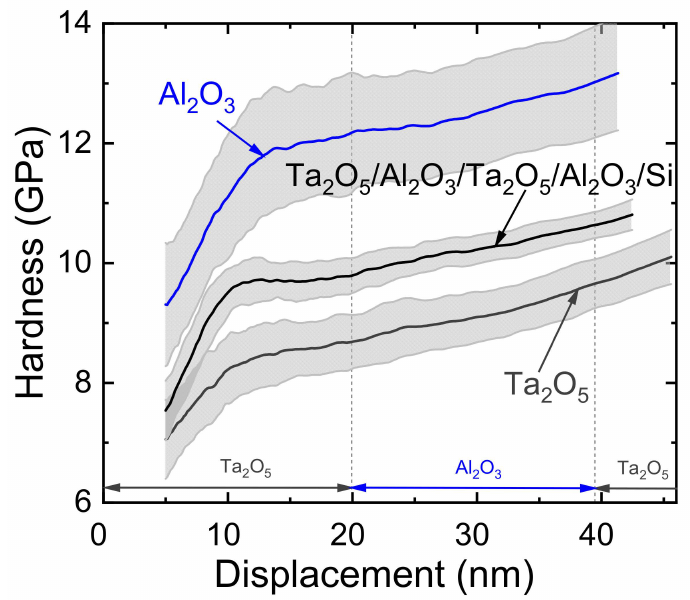
Figure 4. Averaged hardness of 15 indents with standard deviation shown as grey areas. Verti- cal dotted lines and arrows indicate the thickness and sequence of three topmost layers for the Ta 2 O 5 /Al 2 O 3 /Ta 2 O 5 /Al 2 O 3 /Si laminate.